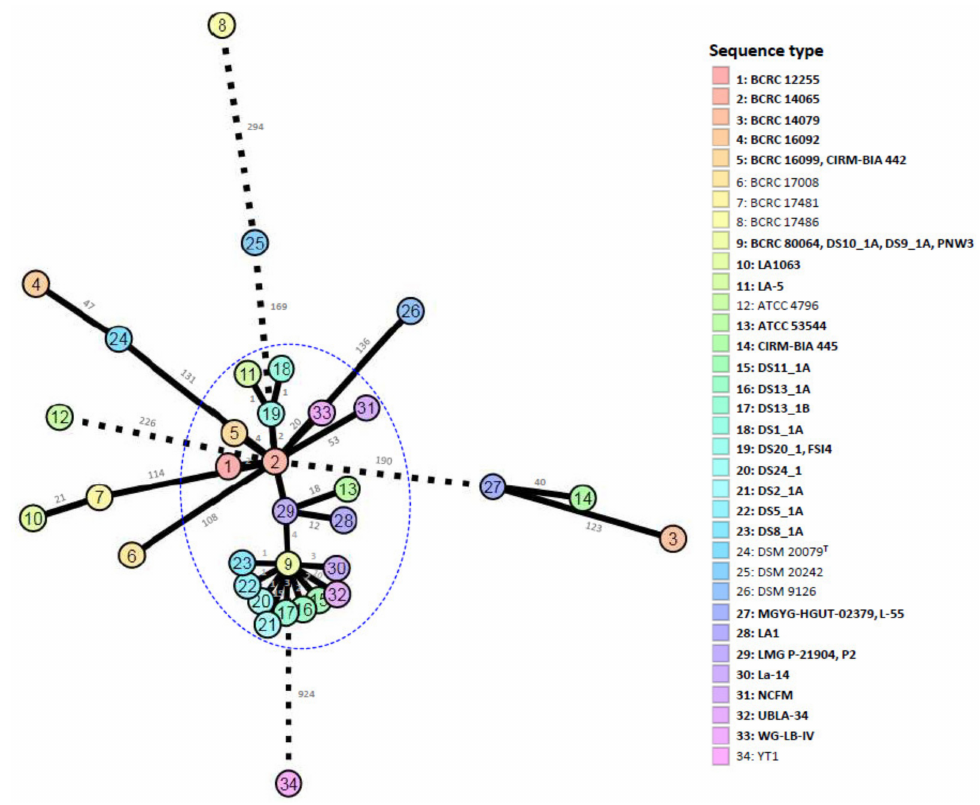
Figure 2. The allele-based minimum spanning tree constructed with cgMLST profiles for the 41 Lactobacillus acidophilus strains on the basis of a comparison of 1390 di ff erentiated core genes. Each circle represents a di ff erent sequence type. Branch values indicate the number of loci that di ff er between nodes.